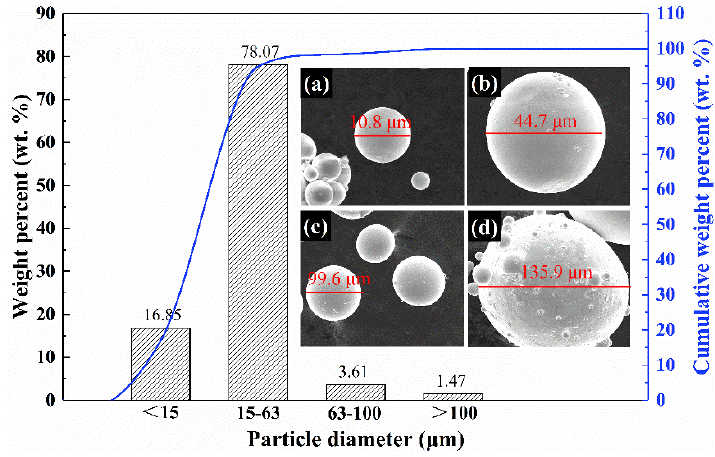
Figure 3. Size distribution and SEM images of the gas-atomized amorphous powders. ( a ) 10.8 µ m, ( b ) 44.7 µ m, ( c ) 99.6 µ m, ( d ) 135.9 µ m.